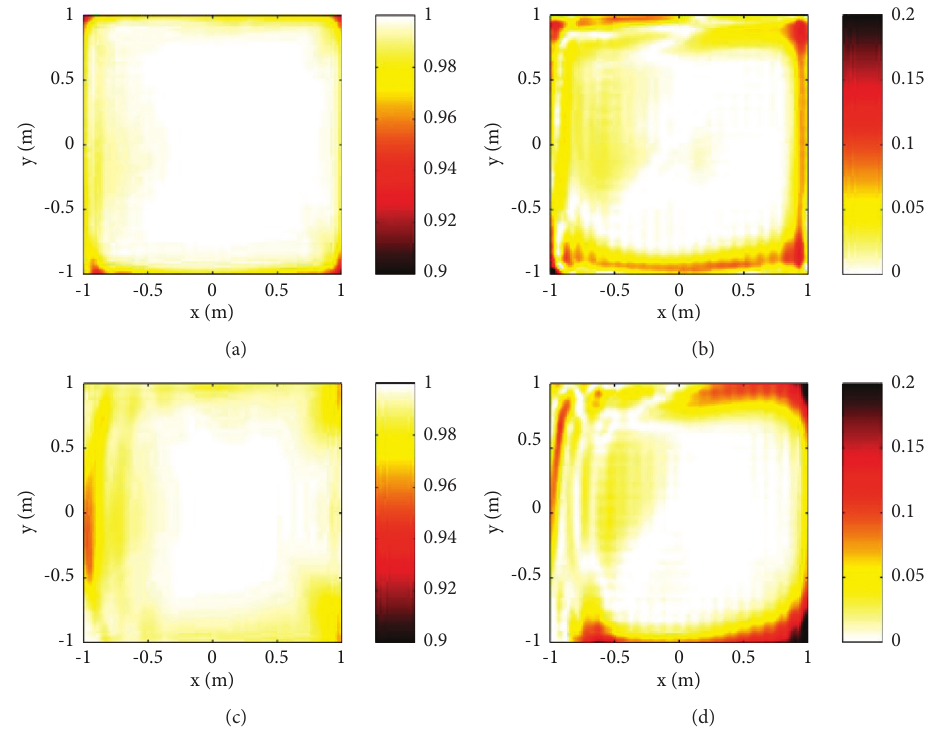
Figure 9: The spatial maps of indicators T 1 and T 2 to assess the phase and the amplitude similarities between the calculated time signals and the theoretical time signals when M � 0.6 on plane z r � 0.2m [(a) and (b)] and on plane z r � 0.5m [(c) and (d)].